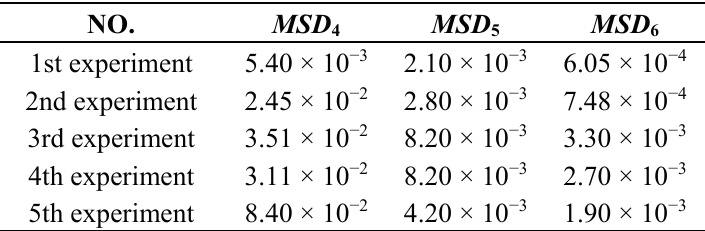
Table 4. MSD from NO.2